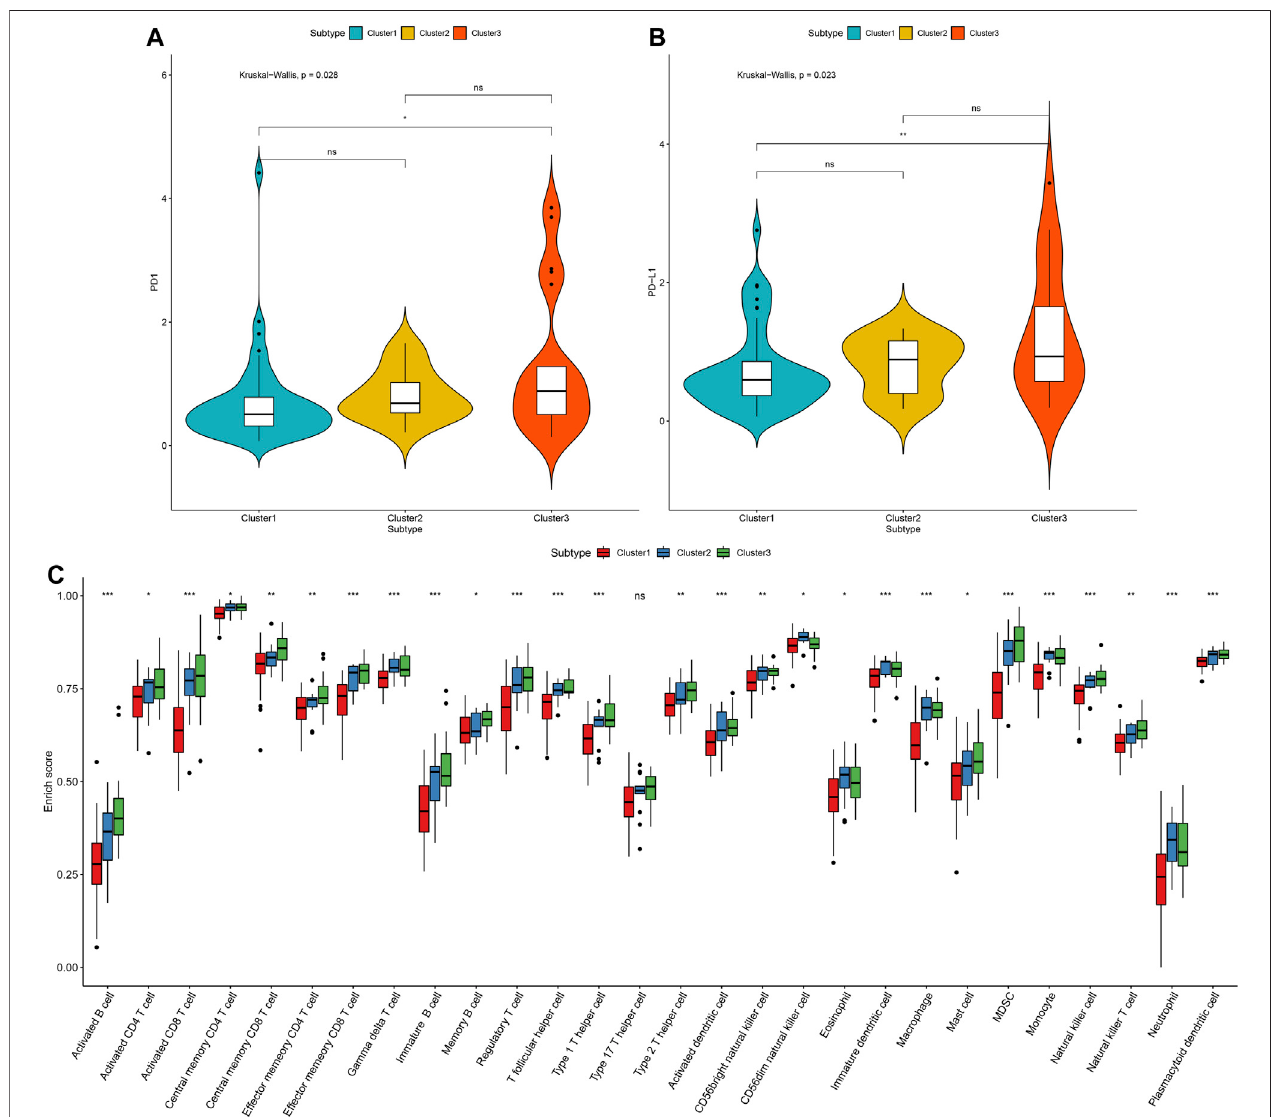
FIGURE 10 | Tumor immune microenvironment characteristics in distinct stromal – immune score-based modi fi cation patterns for osteosarcoma in the TARGET cohort. (A) Comparisons of PD-1 expression across three stromal-immune score-based gene clusters. (B) Relative distribution of PD-L1 expression in three clusters. The differences between three subtypes were compared by Kruskal – Wallis test. (C) The fractions of tumor-in fi ltrating immune cells in three clusters with the ssGSEA algorithm.ThestatisticaldifferencesbetweenclusterswerecomparedwiththeKruskal – Wallistest.ns,nostatisticalsigni fi cance.* p < 0.05;** p < 0.01;*** p < 0.001.